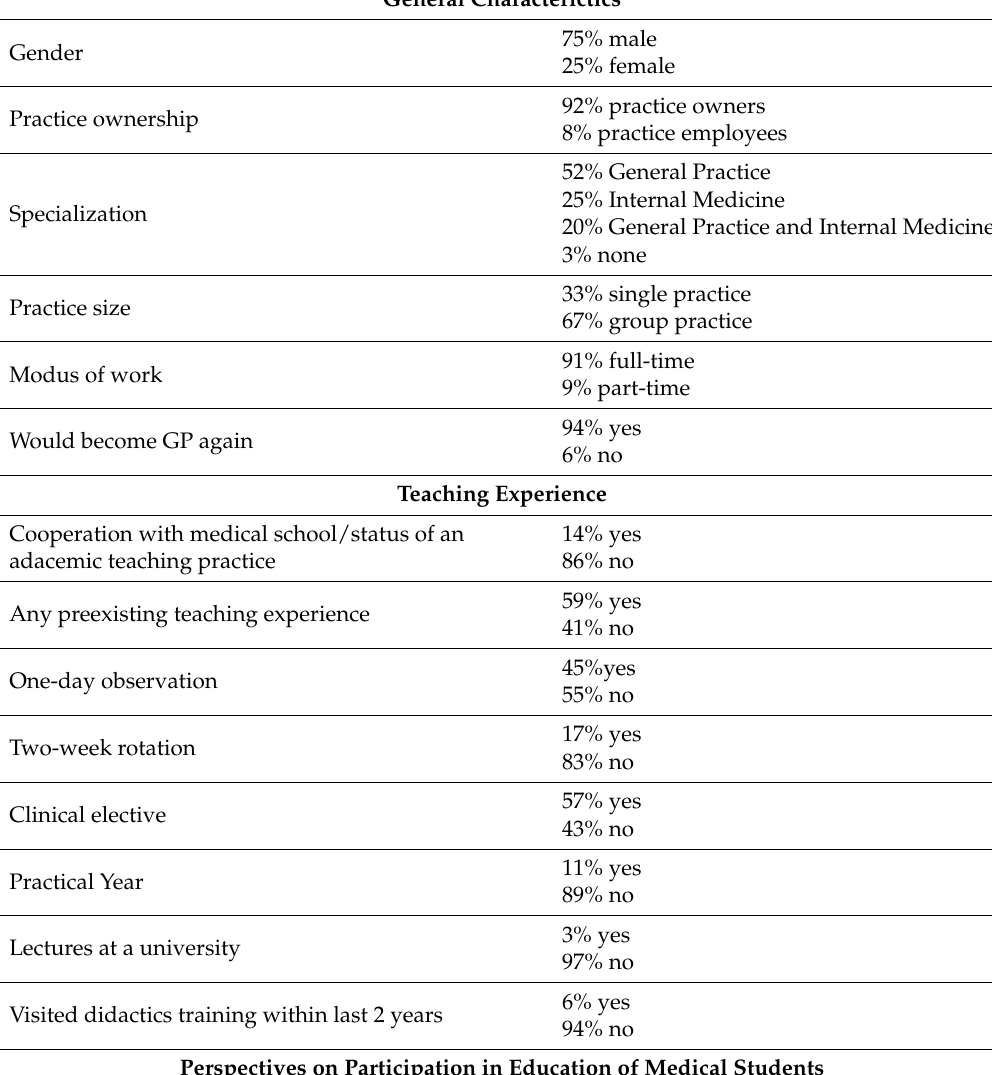
Table 1. Demographic characteristics of study participants ( n =